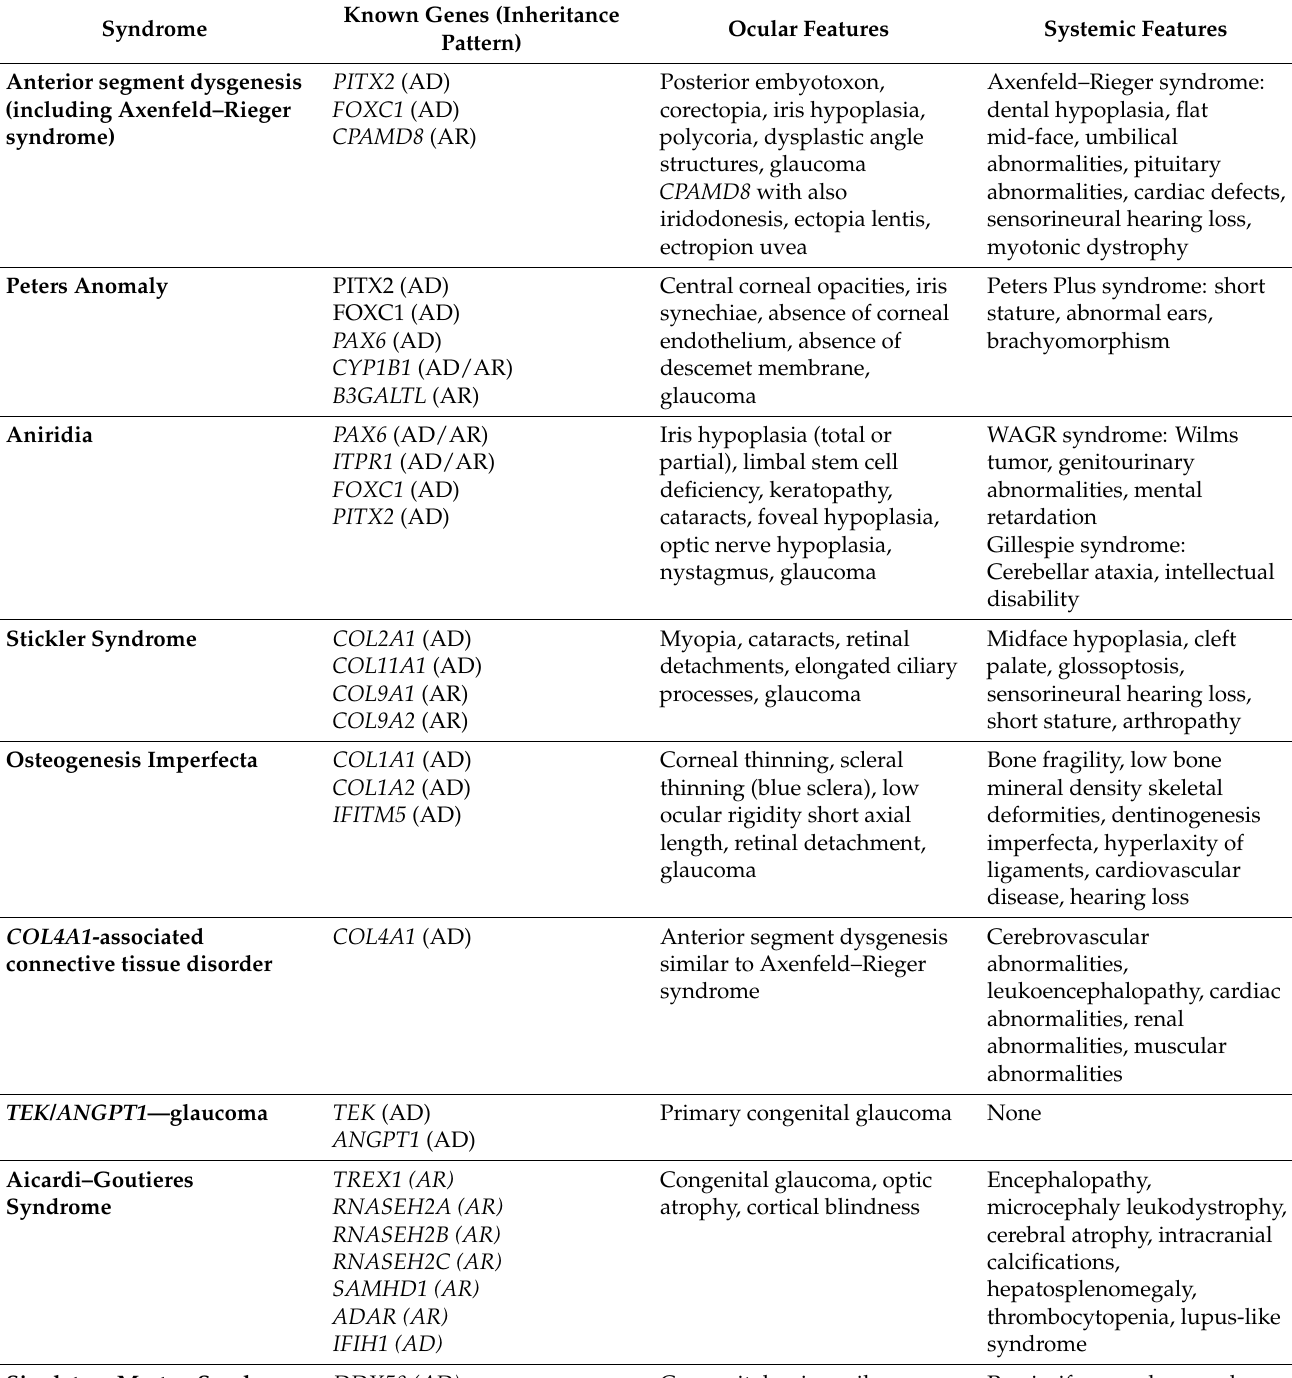
Table 1. Features of glaucoma